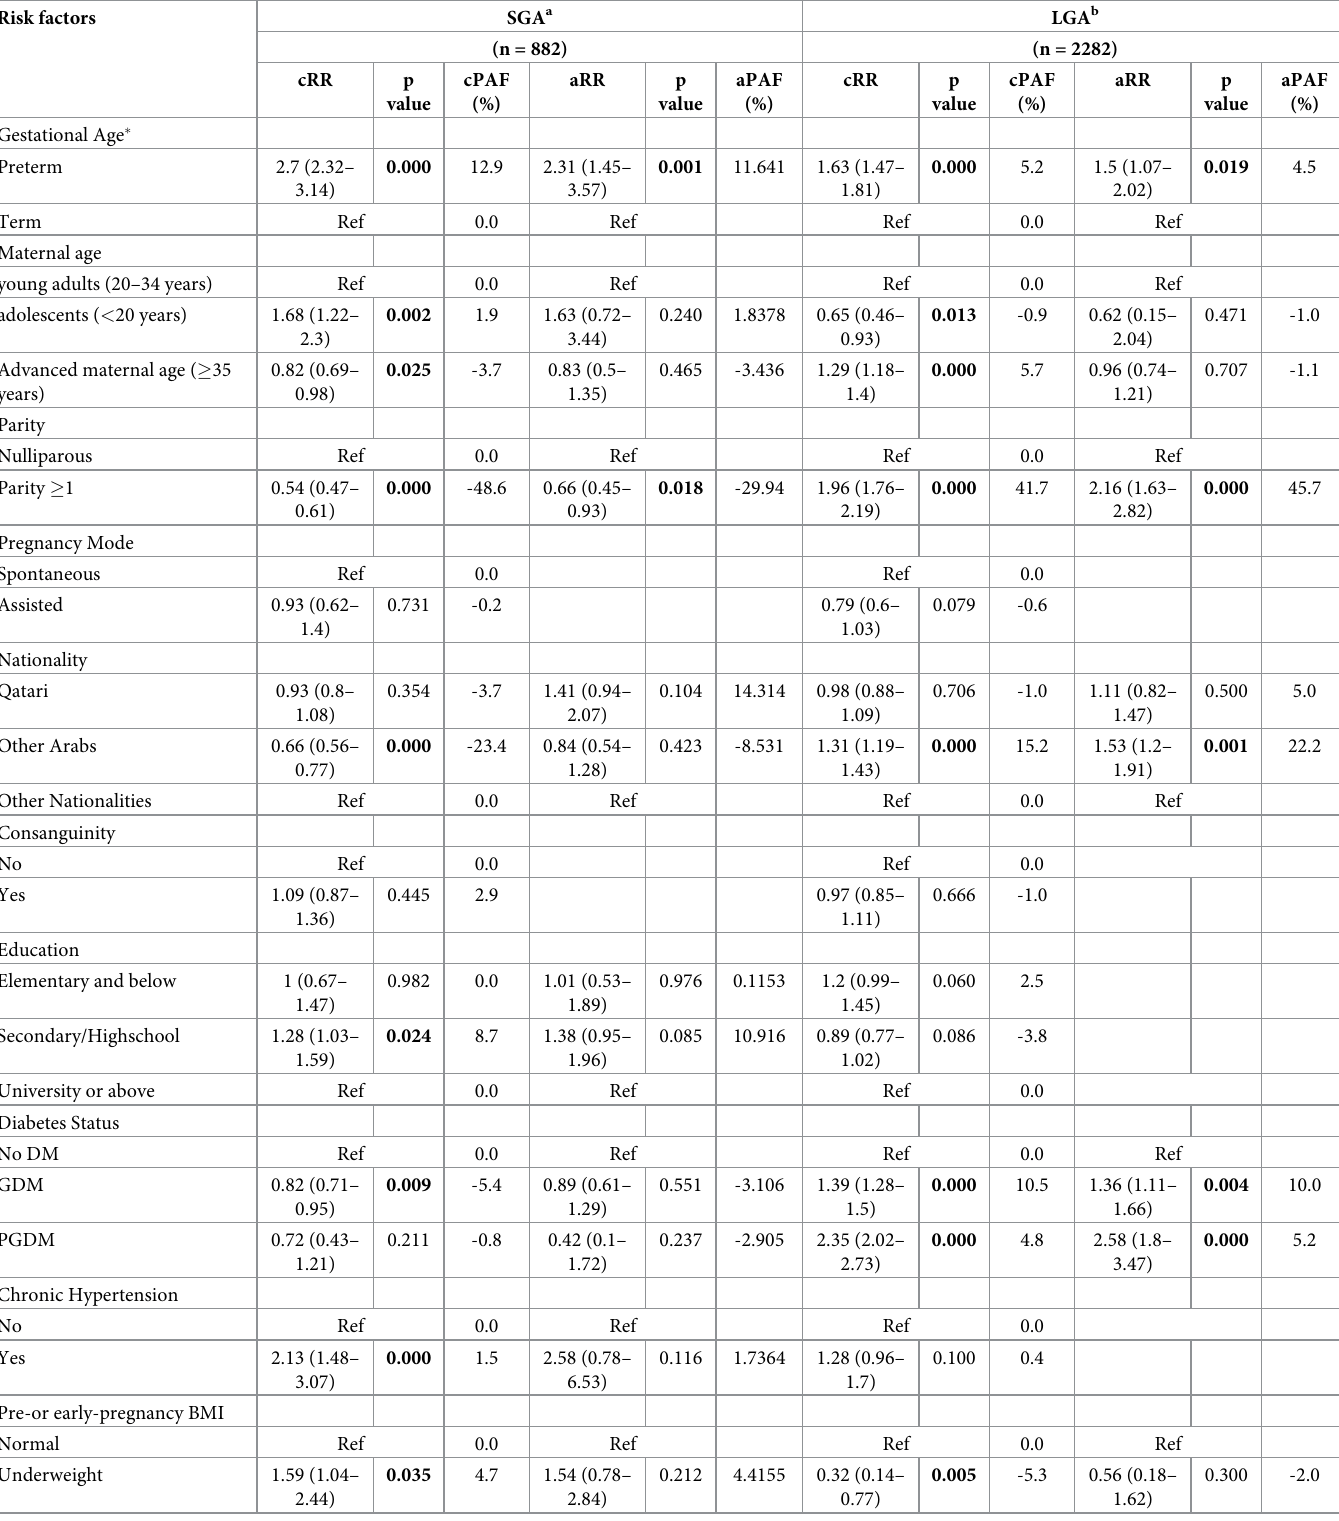
Table 2. Risk factors associated with SGA and